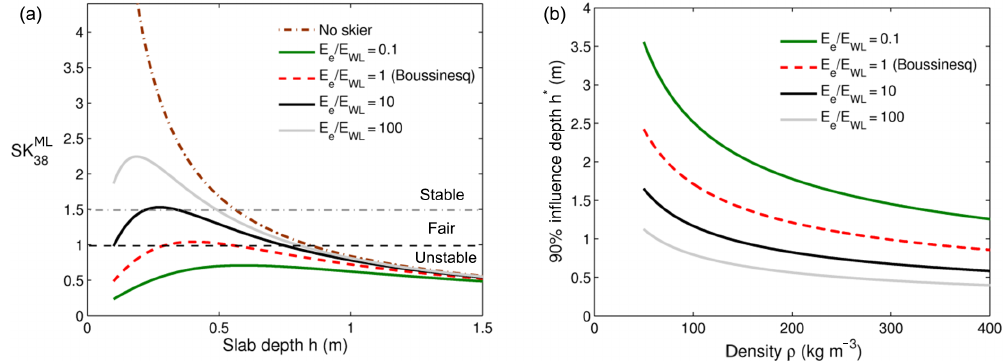
and for a case WL